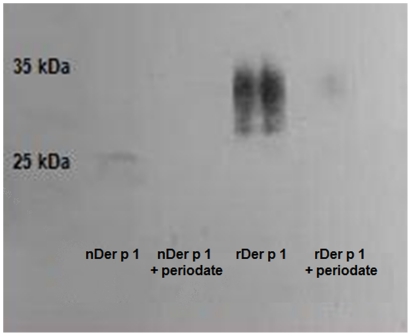
Western blot against GNA (anti-mannose) of natural and recombinant Der p 1 before and after periodate treatment.The blot shows minimal reaction with GNA for both preparations after periodate treatment, indicating that periodate removed most of the mannan. The concentration of the protein loaded in each well was 2.0 µg/ml.